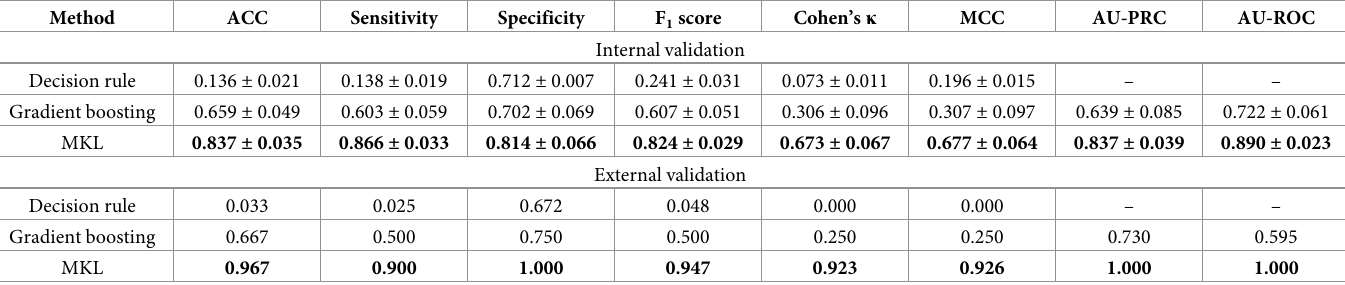
Table 2. Performance estimates for other state-of-the-art models and phenotypic multi-task multi-kernel learning (MKL). For internal validation, each model was assessed by nested k-fold cross-validation. For external validation on a set of novel missense variants, the web-based tools for the Gradient boosting and decision rule method were used (see ‘Validation’). Note that AU-PRC and AU-ROC are not available for the decision rule as it is not a probabilistic classifier. Phenotypic learning out- performs other models across all metrics and is shown in bold. Abbreviations: ACC–accuracy; AU-PRC–area under the precision recall curve; AU-ROC–area under the receiver operator characteristics